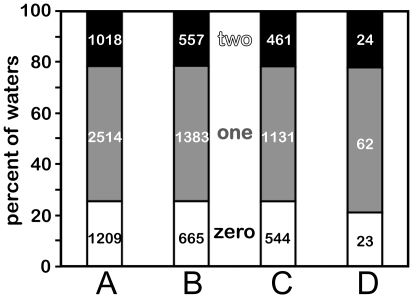
Relative fractions of waters with Relevance to neither (white), one (gray) and both (black) proteins for.(A) full data set of 4741 waters from 179 protein X-ray structures of resolutions ≤ 2.3 Å; (B) reduced data set of 2605 waters from 87 structures of resolutions ≤ 1.90 Å; (C) reduced data set of 2136 waters from 92 protein structures of resolutions between 1.91 Å and 2.3 Å; and (D) 109 waters from 16 structures with resolutions between 2.4 Å and 3.5 Å.